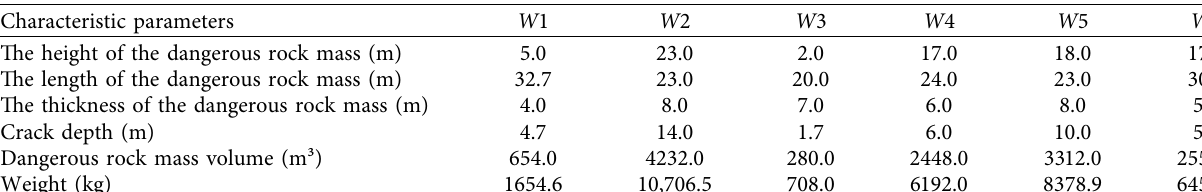
Table 1: Basic parameters of the dangerous rock mass.